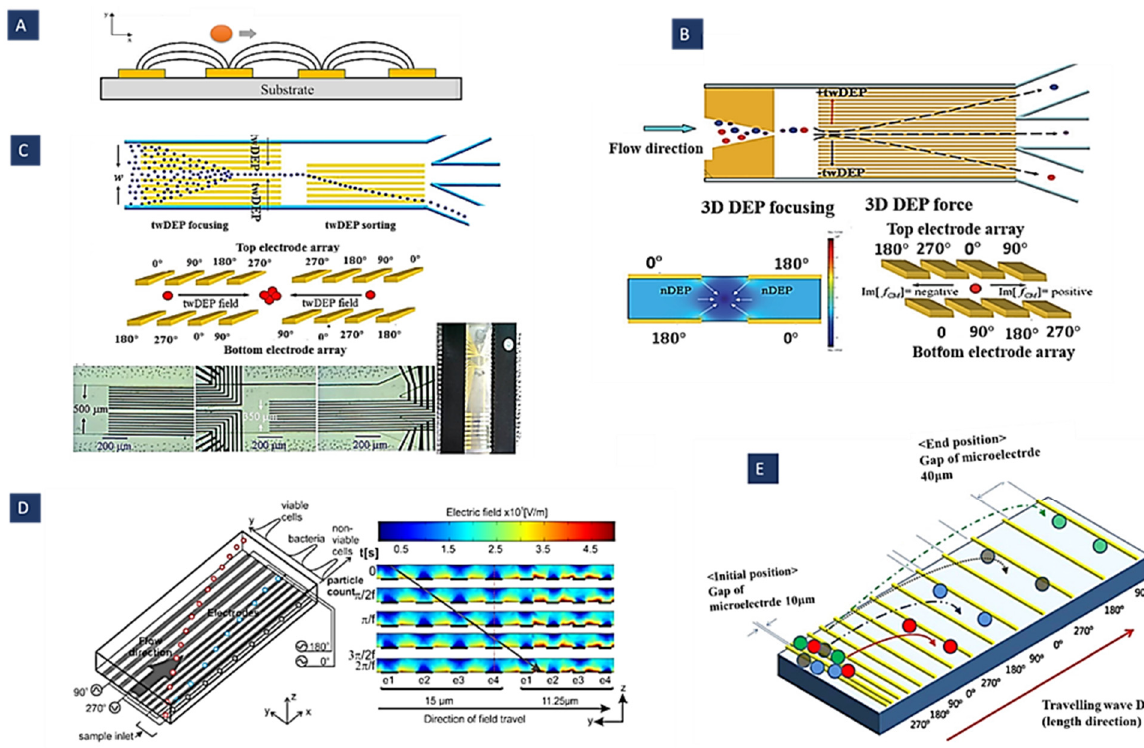
Figure 6. ( A ) Particle exposed to twDEP; ( B , C ) schematic diagrams of continuous high-throughput particle sorters. These methods are based on 3D twDEP separation of microparticles into different downstream sub-channels according to differences in their twDEP mobilities (Reprinted with per- mission from [67,68]. Copyright 2009, Royal Society of Chemistry and Copyright 2010, Springer, respectively); ( D ) separation of cells and bacteria by twDEP using gradient electrode (Reprinted with permission from [69]. Copyright 2011, Elsevier); ( E ) separation, trapping, and channeling of microparticles based on their physical parameters using twDEP (Reprinted with permission from [103]. Copyright 2009, Institute of Physics (IOP) Publishing).